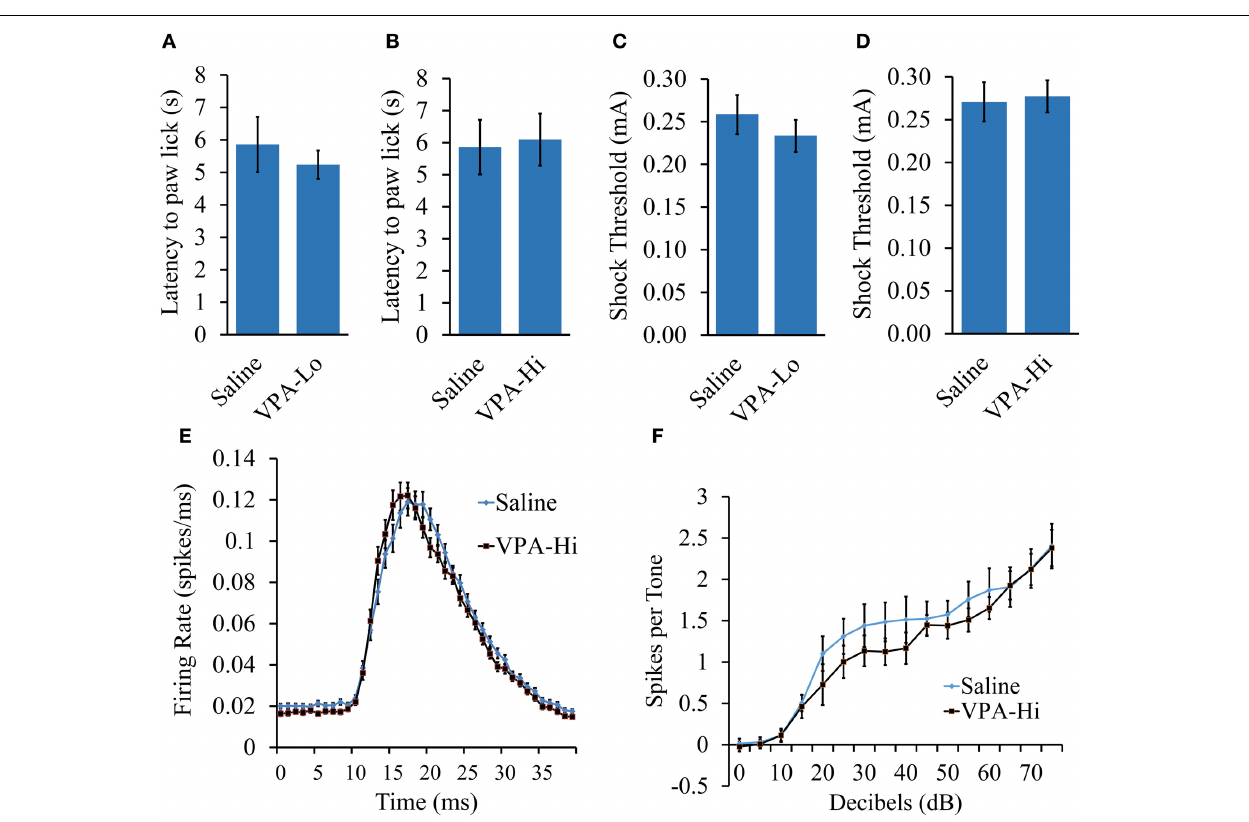
FIGURE 3 | The fear conditioning deficit observed in progeny from VPA-Hi exposed dams is likely not due to deficits in sensory modalities necessary for auditory fear conditioning. (A) Thermal nociception as measured by the hotplate test did not differ between progeny from VPA-Lo and saline exposed dams (Saline = 12, VPA-Lo = 12) (B) or progeny from VPA-Hi and saline exposed dams (Saline = 12, VPA-Lo = 11) (C) Response to foot shock stimuli did not differ between progeny from VPA-Lo and saline exposed dams (Saline = 10,